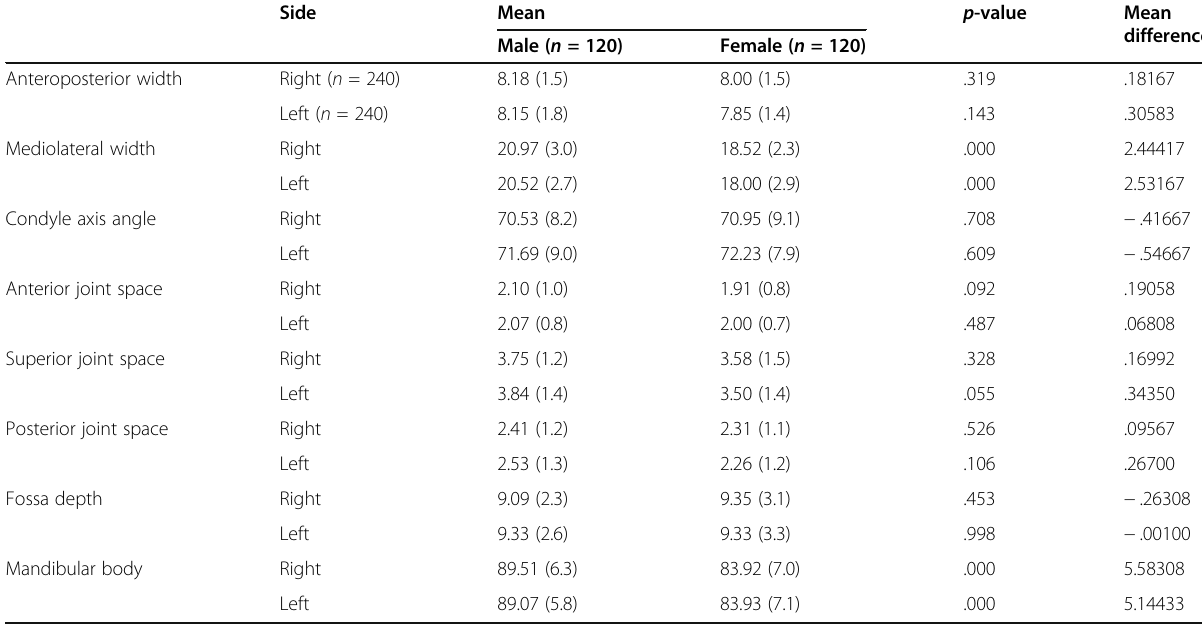
Table 3 Table comparing male and female based on left and right side Side Anteroposterior width